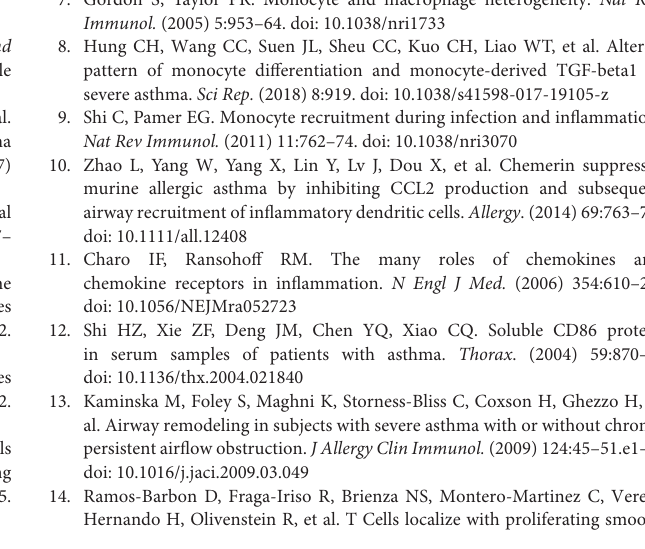
Figure S4 | Human rhinovirus infection induces IL-6 expression by bronchial epithelial cells. IL-6 was quantified in supernatants of BE cells infected by HRV or UV-inactivated HRV. Data are presented as mean ± SEM values ( n = 6 per group, one-way ANOVA, Bonferroni’s multiple comparisons test, ∗∗∗ P < 0.001). Table S1 | Patients’ characteristics for BSM. Table S2 | Control subjects’ characteristics for BE. Table S3 | Asthmatic patients’ characteristics for